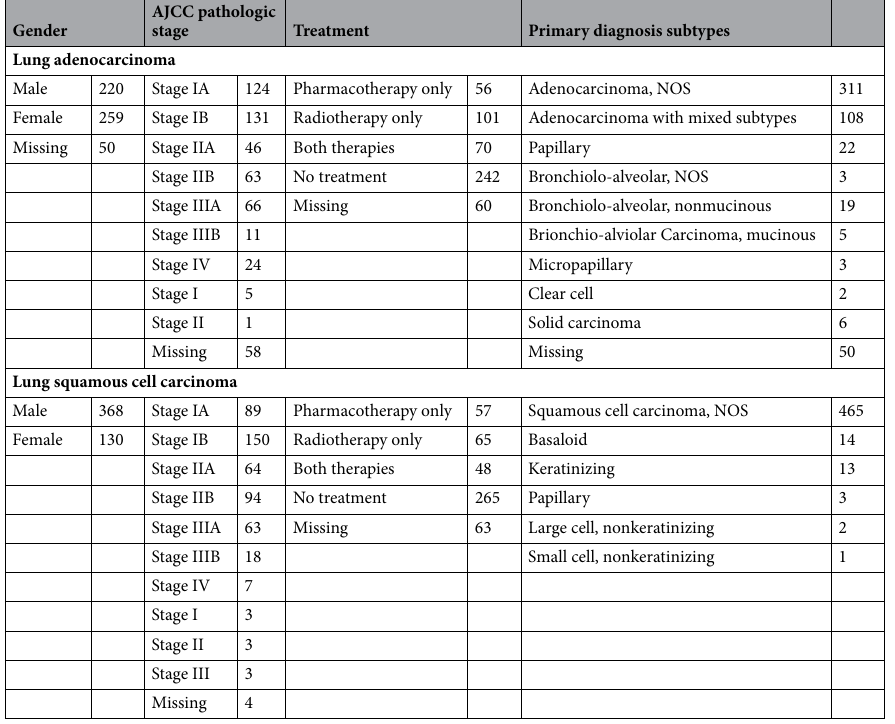
Table 1. Summary of clinical information from TCGA with each entry indicating number of samples.